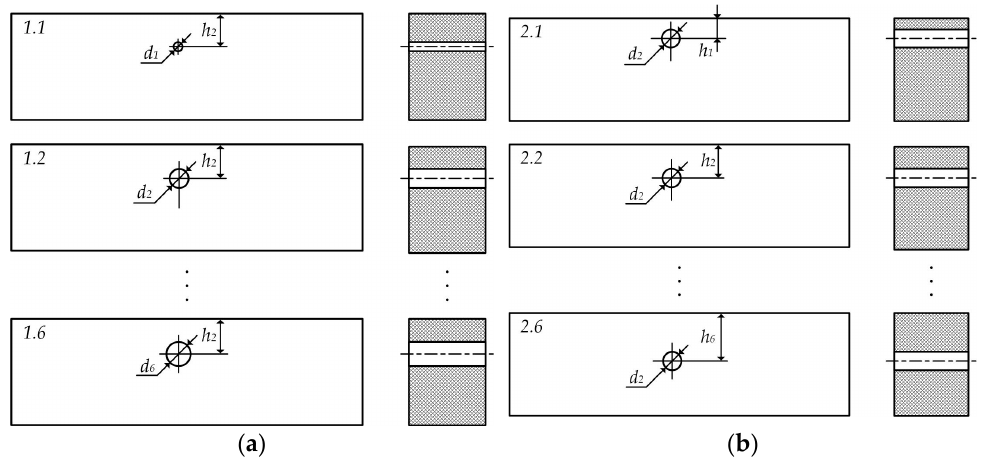
Figure 8. RS Subset with Subsurface Flaws: First Subset ( a ) and the Second RS Subset ( b ). The dimensions of the RS flaws in the form of side cylindrical holes and their proba- ble depths are given in Table 1. Table 1. The dimensions of the RS flaws.